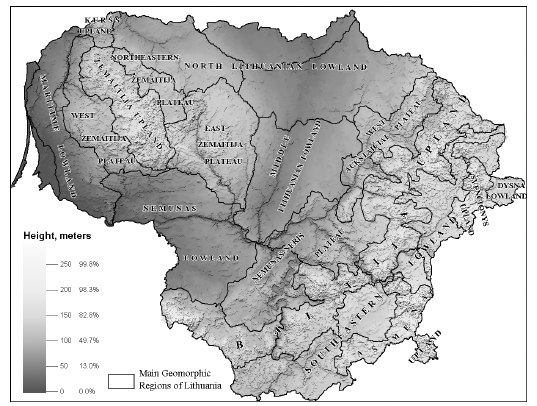
Fig 1 . Digital terrain model and main geomorphic regions